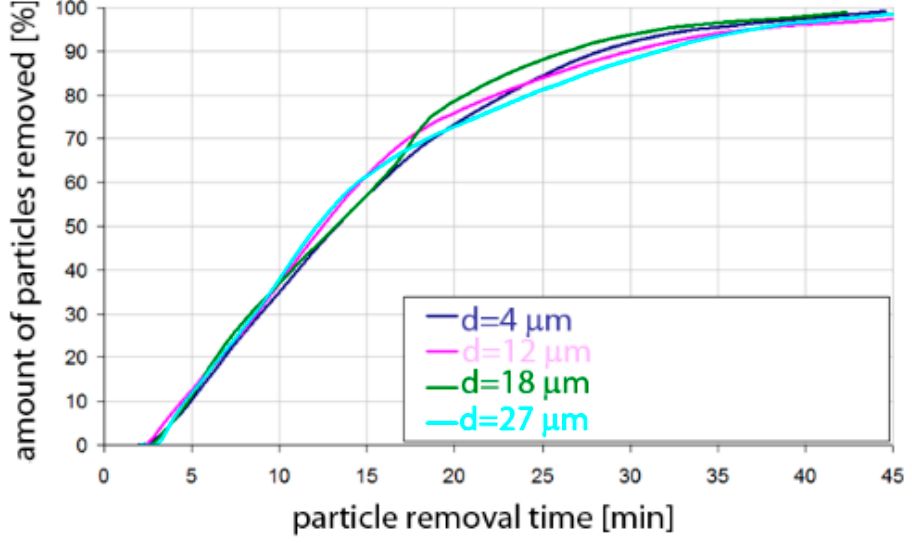
Figure 15. Share of removed non-metallic Al 2 O 3 inclusions from the analysed ladle in the case of argon flow of 25 L/min through the 18CrNiMo7-6 steel.